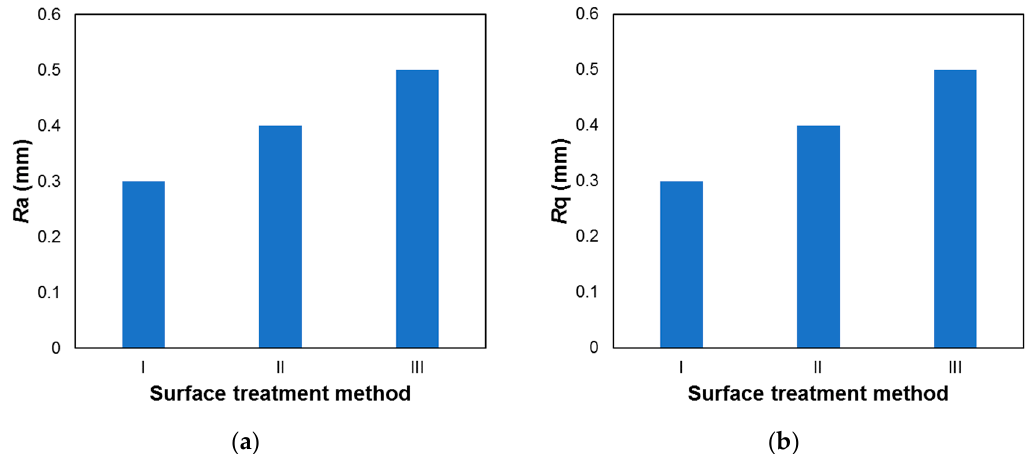
Figure 11. The effect of the surface treatment method on the value of: ( a ) arithmetical mean height ( R a) of the concrete surface, ( b ) root mean square deviation ( R q) of the concrete surface. The surface treatment methods were marked as follows: I—as cast surface, II—wire-brushed surface, III—sand-blasted surface (based on the results presented in Reference [49]).